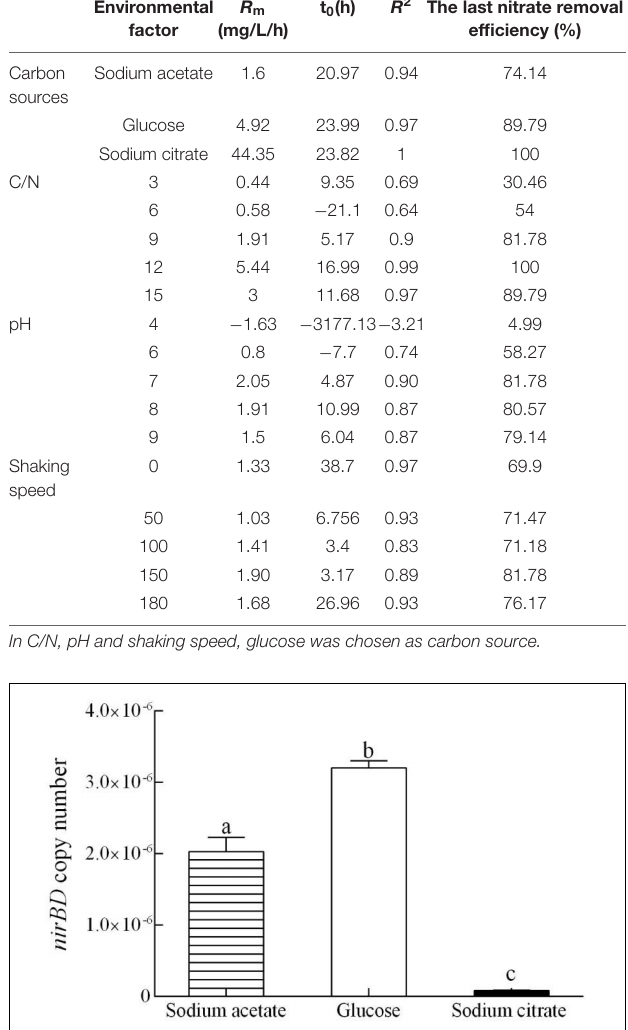
TABLE 1 | Kinetic parameters and final removal efficiency for the degradation of nitrate by strain Y-9 under different environmental conditions. Environmental factor